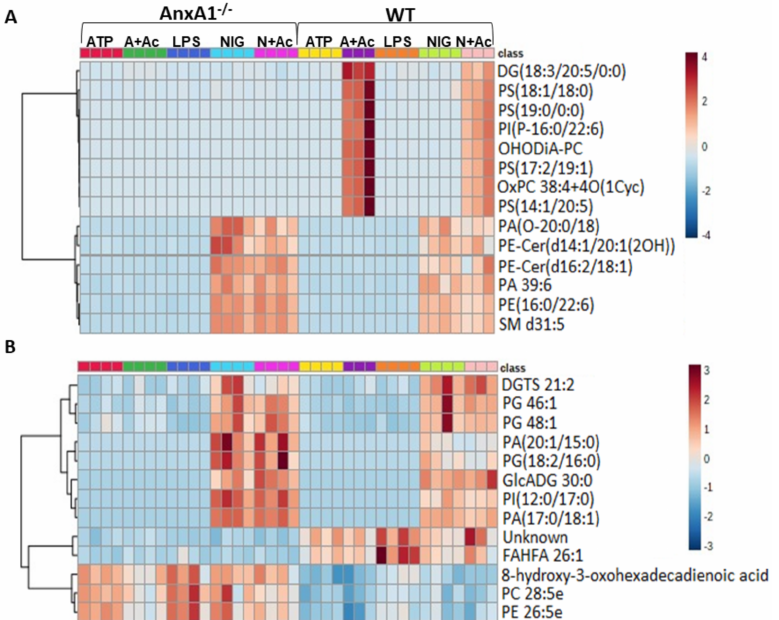
Figure 3. Lipidomic analysis of WT and AnxA1 -/- neutrophils supernatants. Heatmaps with dendro- grams show the hierarchical clustering of potential lipid biomarkers. ( A ) Positive mode. ( B ) Negative mode. The right bar in ( A , B ) represents the blue-red code ( − 4 to 4 for positive and − 3 to 3 for negative mode) of the lipid normalized peak areas. WT and AnxA1 -/- neutrophils were primed with lipopolysaccharide (LPS) and then stimulated with ATP, ATP with Ac 2-26 pre-treatment (A + Ac), nigericin (NIG), and nigericin with Ac 2-26 pre-treatment (N + Ac). Table S1 (Supplementary Mate- rial) shows the relevant chemical and statistical information for the discriminant lipids. Data are representative of one experiment